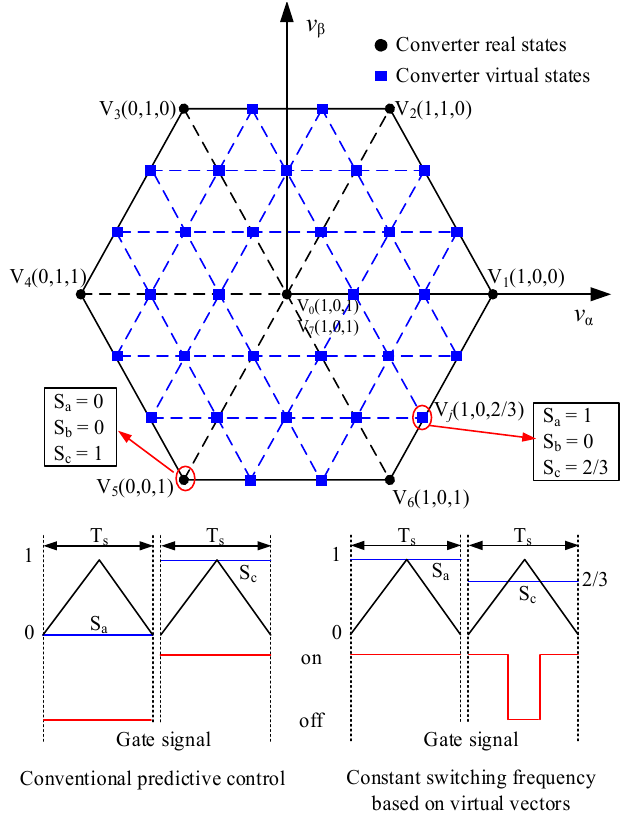
Figure 2. Space vector diagram in the αβ frame, including virtual states.